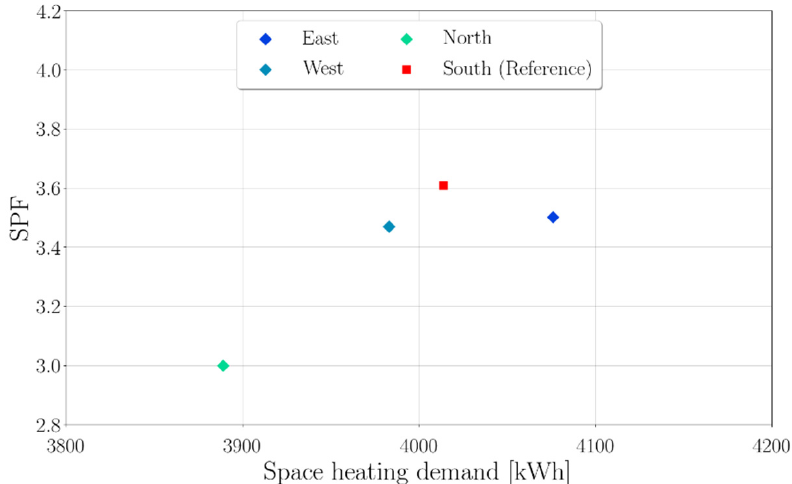
Figure 26. SPF versus the space heating demand for different building orientations. The orientations